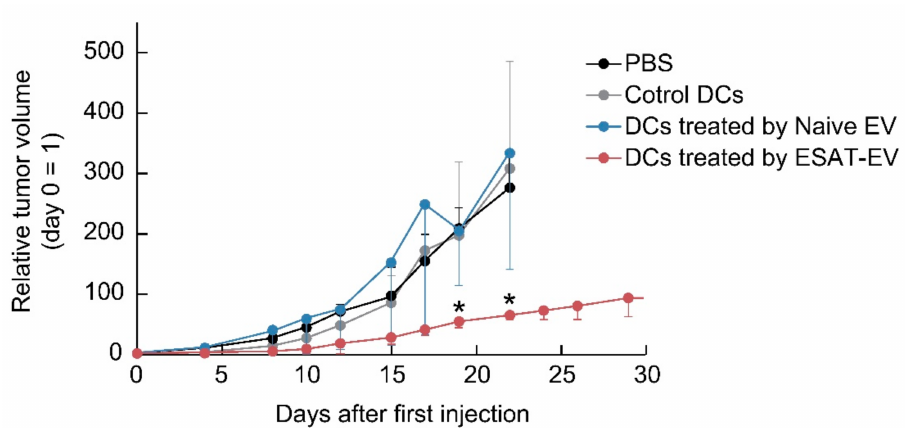
Figure 8. Anti-tumor therapeutic efficacy of DCs treated by EVs. Bone marrow-derived DCs were treated with ESAT-EV, Naive EV, or PBS (as control DCs) for 24 h. Mice bearing B16 tumor were injected intratumorally with the DCs, and the tumor growth was monitored. The tumor volume is calculated as (a × b 2 )/2, where a is the largest and b is the smallest diameter of the tumor and expressed as the ratio between the tumor volume in each time point and at the beginning of the treatment ( n = 4, mean ± SD, * p < 0.05 vs. DCs treated by Naive